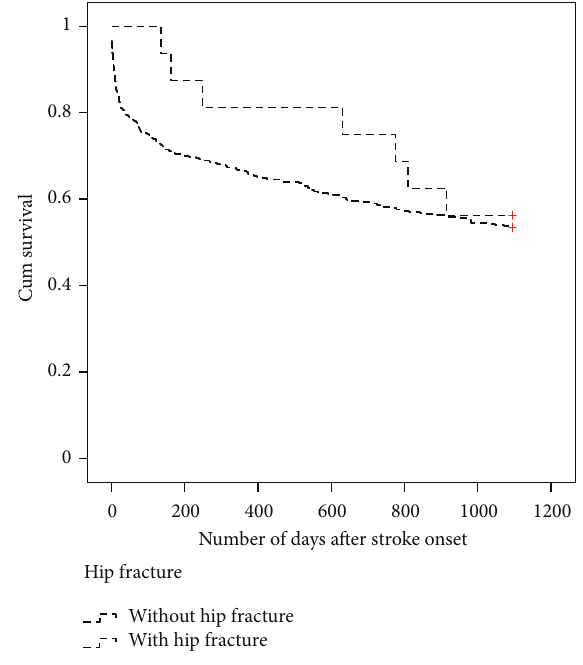
Figure 1: The survival time three years after stroke onset for persons with and without hip